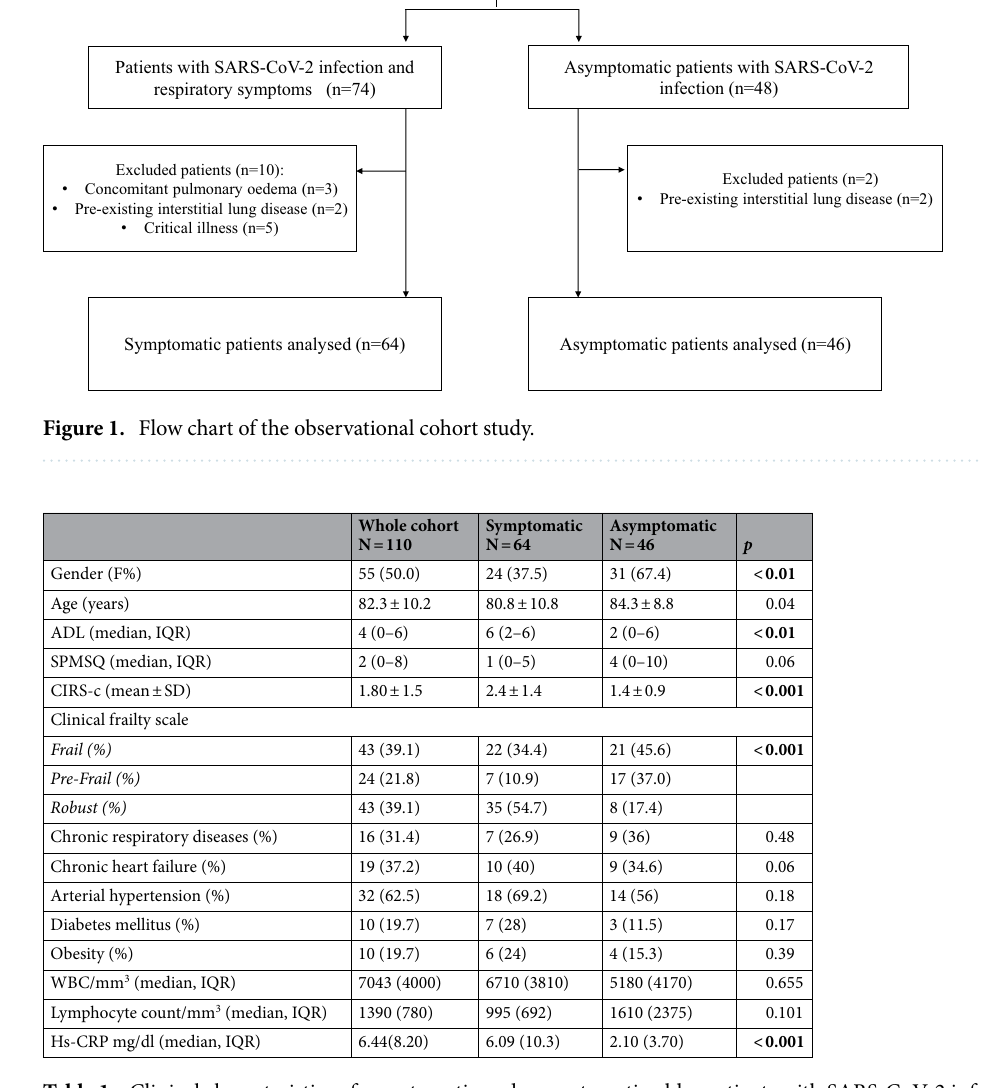
Table 1. Clinical characteristics of symptomatic and asymptomatic older patients with SARS-CoV-2 infection. Data are expressed as mean ± standard deviation, median (interquartile range) and number (%) as appropriate. ADL activities of daily living, CIRS-C cumulative illness rating scale-comorbidity, SPMSQ short portable mental status questionnaire, WBC white blood cells, Hs-CRP high-sensitivity C-reactive protein. Significant p values are marked in